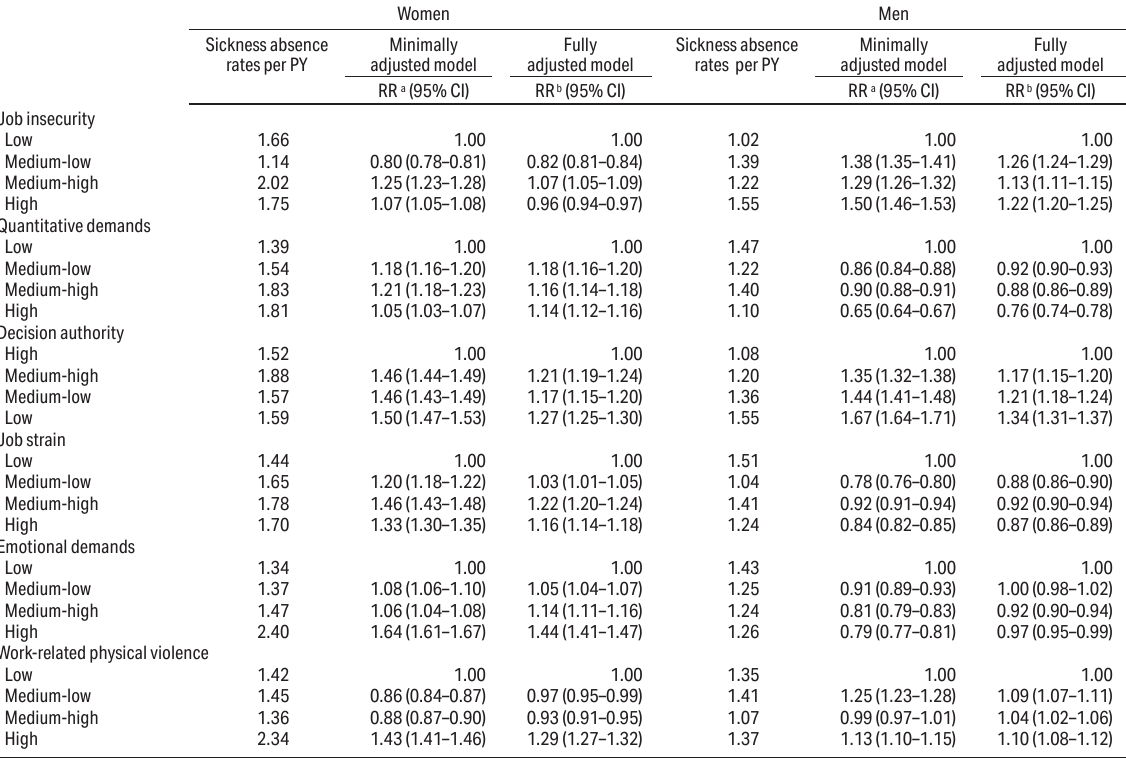
Table 2. Rate ratio (RR) for the association between being employed in occupations with specific psychosocial working conditions and sickness absence of any length (≥1 day) among women (N=160 104) and men (N=141 108). [PY=person-years; CI=confidence interval]